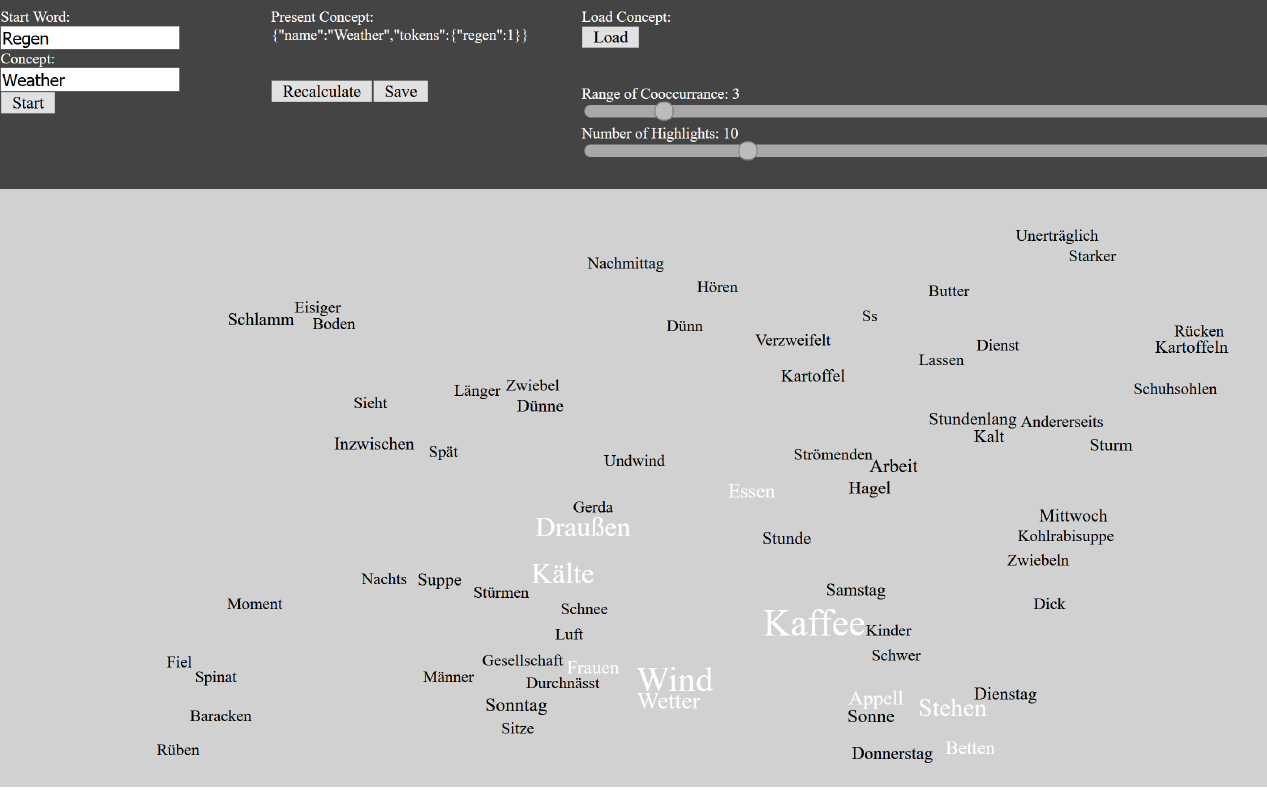
Figure 6. Starting with the ConceptTool requires entering a start token and the name of the concept. This leads to an initial display of co-occurring tokens from the